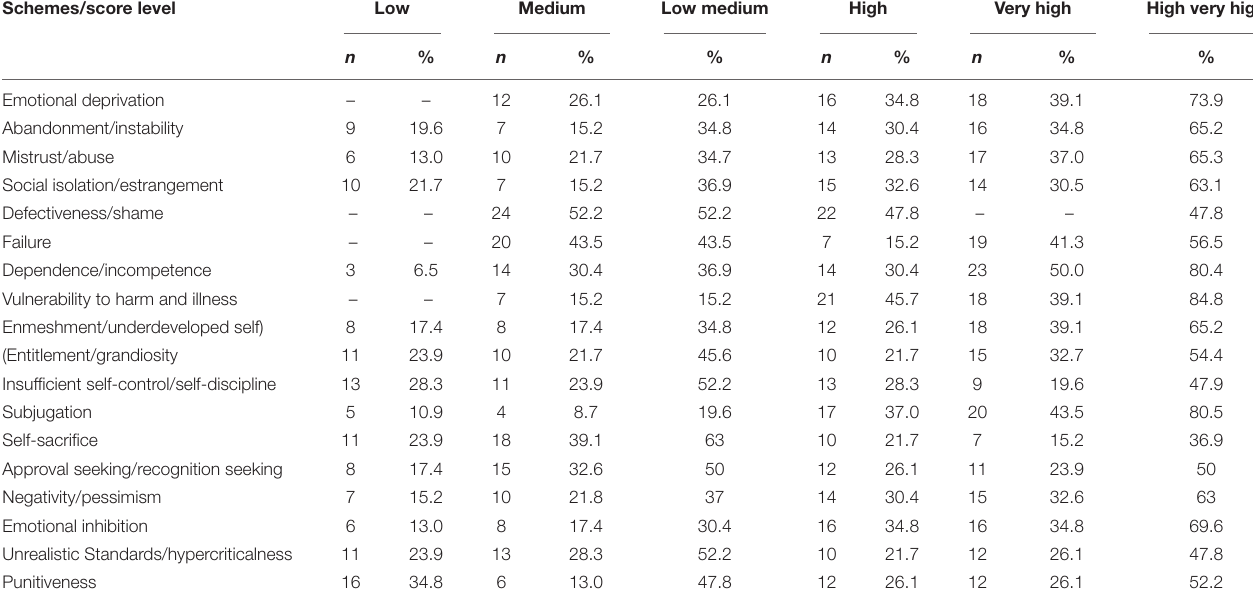
TABLE 3 | Distribution of subjects by domains and maladaptive schemes. Schemes/score